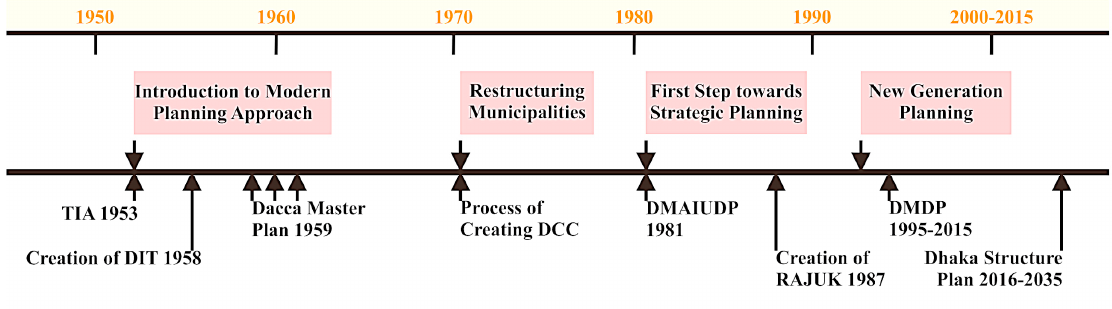
Figure 4. History of Dhaka city development plans.